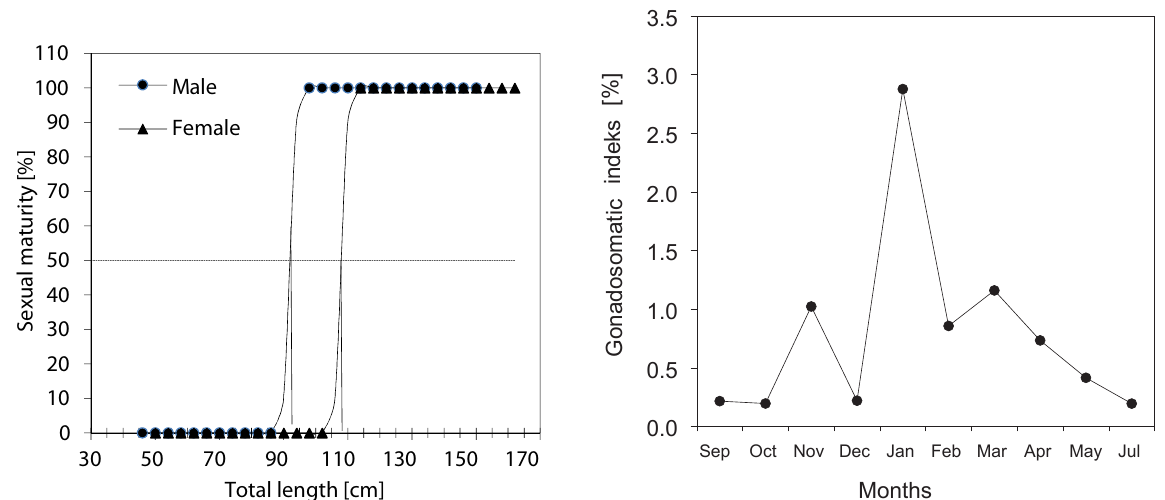
Fig. 11. Monthly fluctuations of gonadosomatic index of Mustelus mustelus from the Gulf of Iskenderun, north- eastern Mediterranean Sea